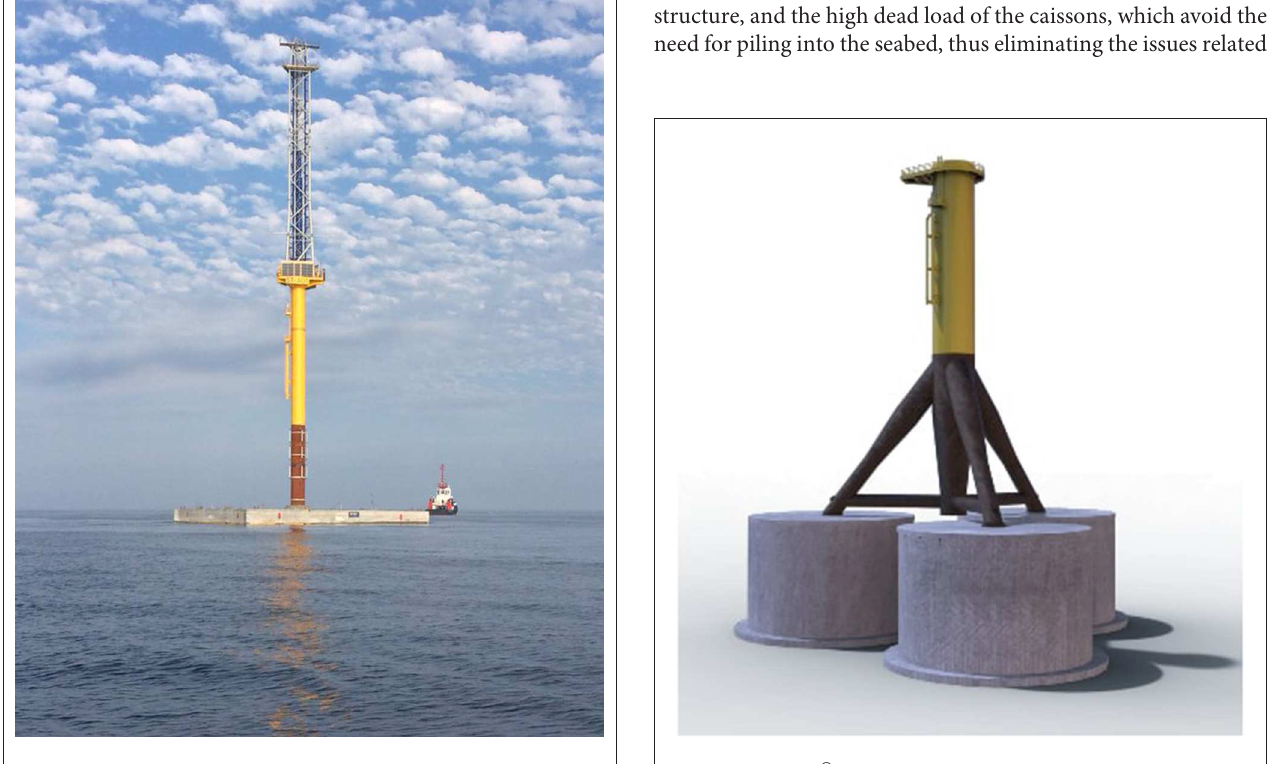
FIGURE 7 | Towing of the Meteorological mast foundation of Moray Firth. FIGURE 8 | GRAVI3 ®